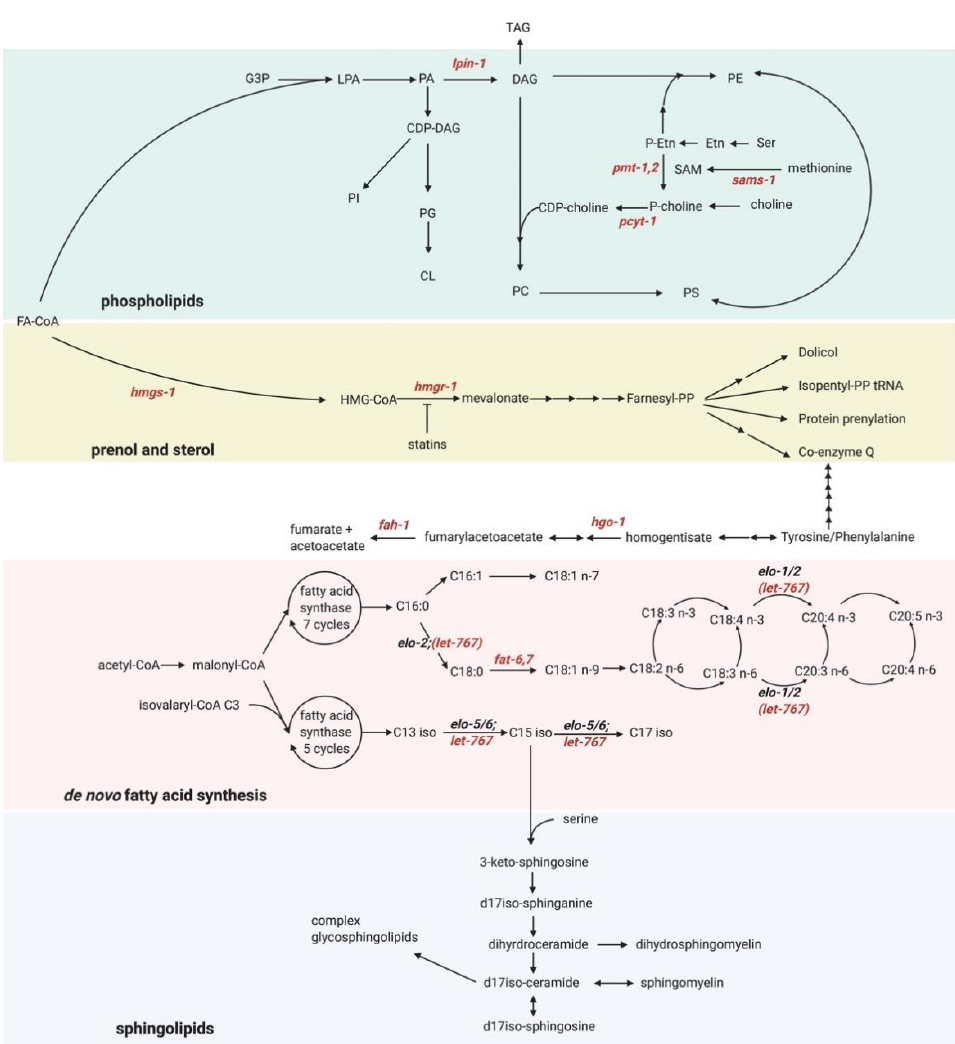
Figure 3. Overview of lipid synthesis pathways in C. elegans (adapted with permission from [143]). Genes colored in red are known to induce the UPR-ER when inactivated. Abbreviations: CDP-Cho: cytidine diphosphate choline;